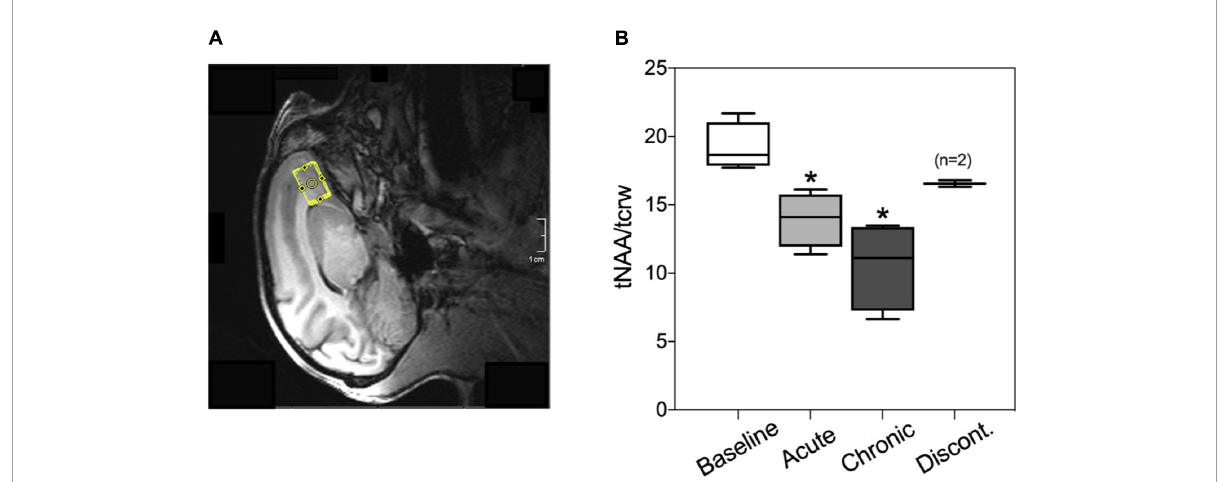
FIGURE5 (A) Representative voxel placement for spectroscopy measurement at medial orbitofrontal cortex (mOFC) in rhesus macaques. (B) Boxplots of N- acetylaspartate/creatine ratio (tNAA/tCrw) during baseline, acute administration of AM2389 (10 µ g/kg), during chronic AM2389 treatment (total dose 0.32 mg/kg), and 30 days after treatment discontinuation. * p < 0.05 vs. Baseline ( N =